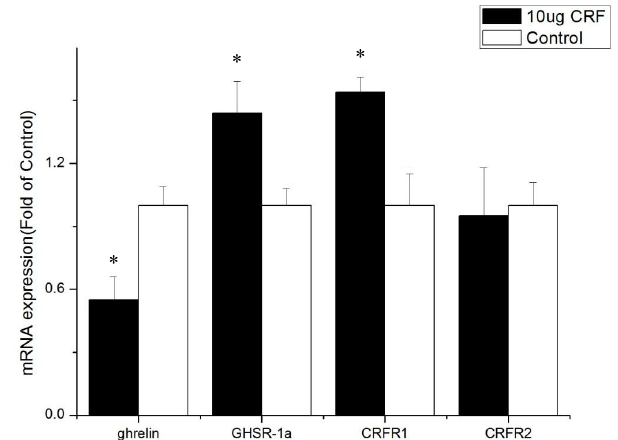
Figure 3. Effect of intracerebroventricular injection of corticotro- pin-releasing factor (CRF) on genes in the duodenum of broiler chick- ens. Control = control group (basal diet); 10 μg = 10 μg/kg body weight; n = 8. * p<0.05 (compared with control).